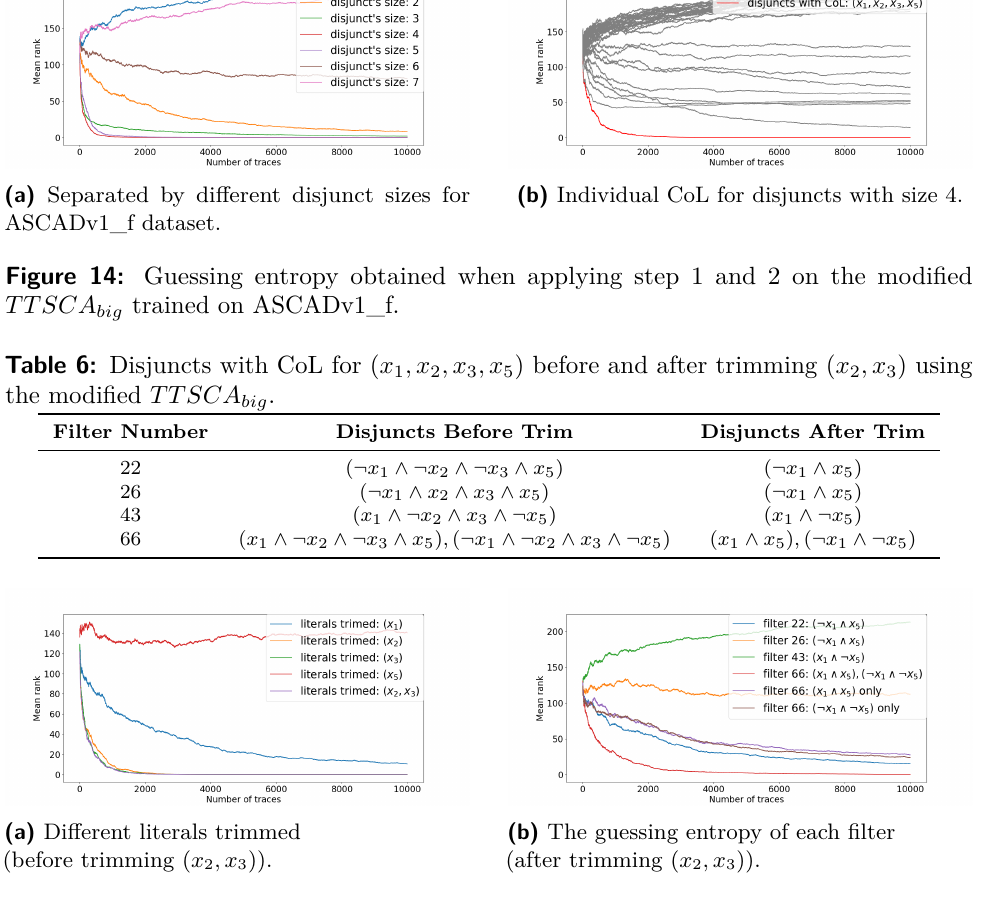
Figure 15: Guessing entropy of the CoL for ( x 1 , x 2 , x 3 , x 5 ) obtained from the modified TTSCA big (i.e., before and after trimming ( x 2 , x 3